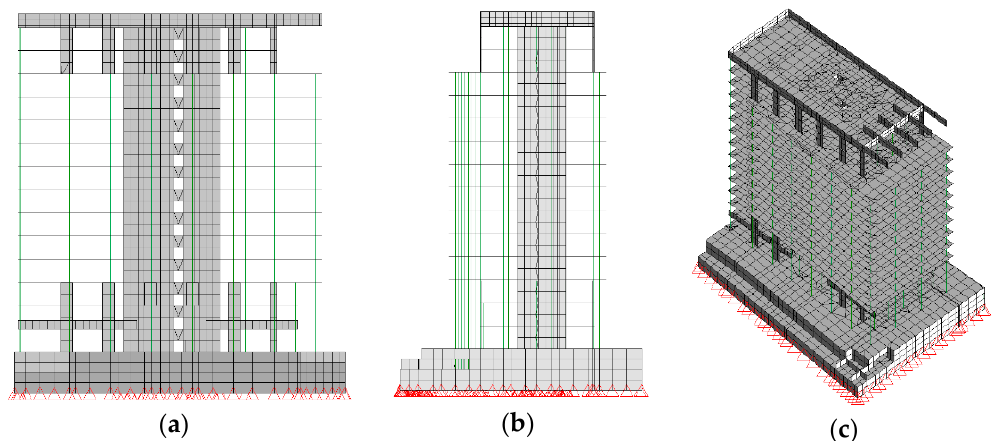
Figure 18. FEM model of the structure: ( a ) front view; ( b ) side view; ( c ) axonometric view.